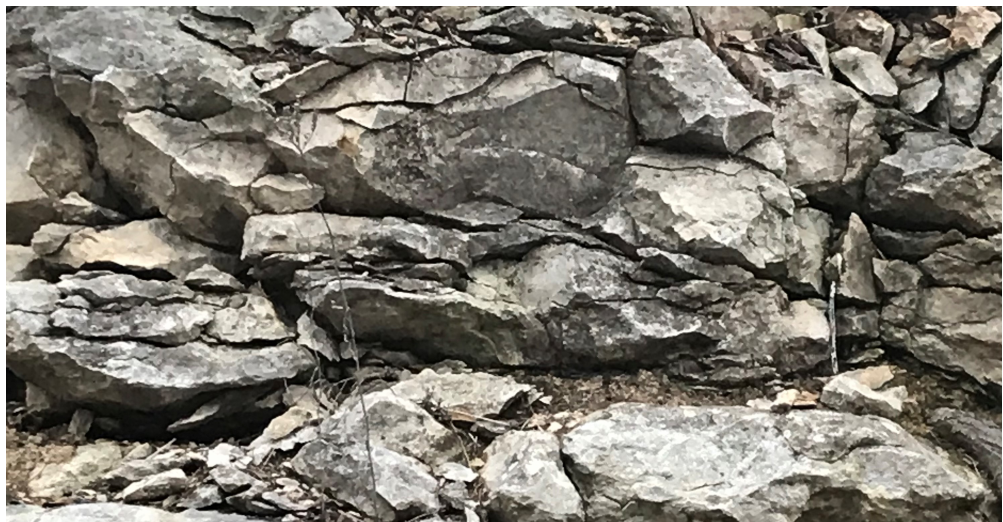
Figure 4. Picture of the fractured formation in the study area (scale is 0.5m 2 ).